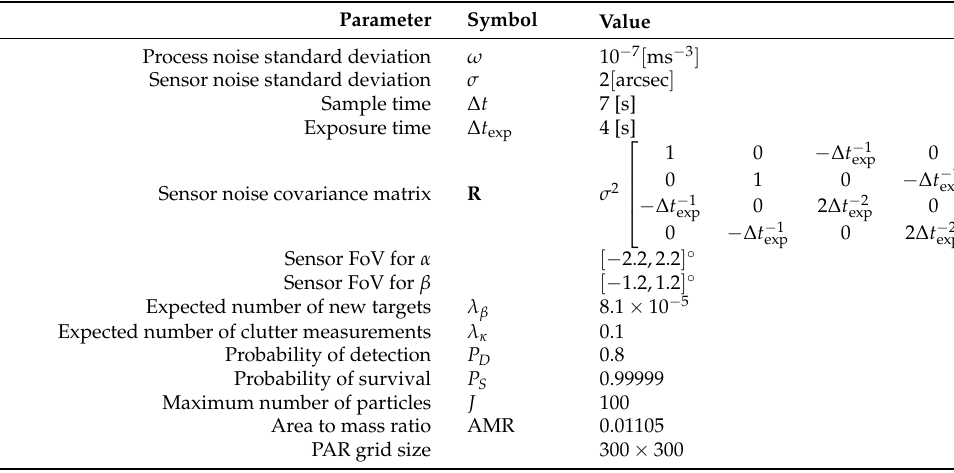
Table 2. Parameters of the experiment.